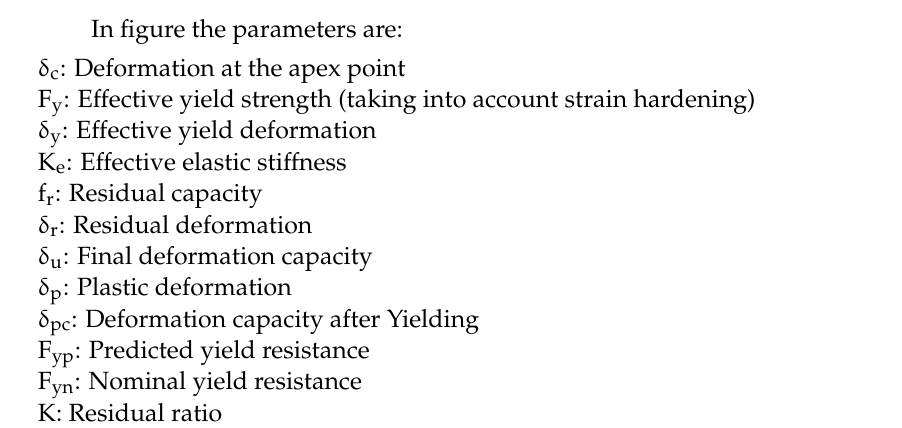
Figure 9. Modified Ibarra–Krawinkler Model.